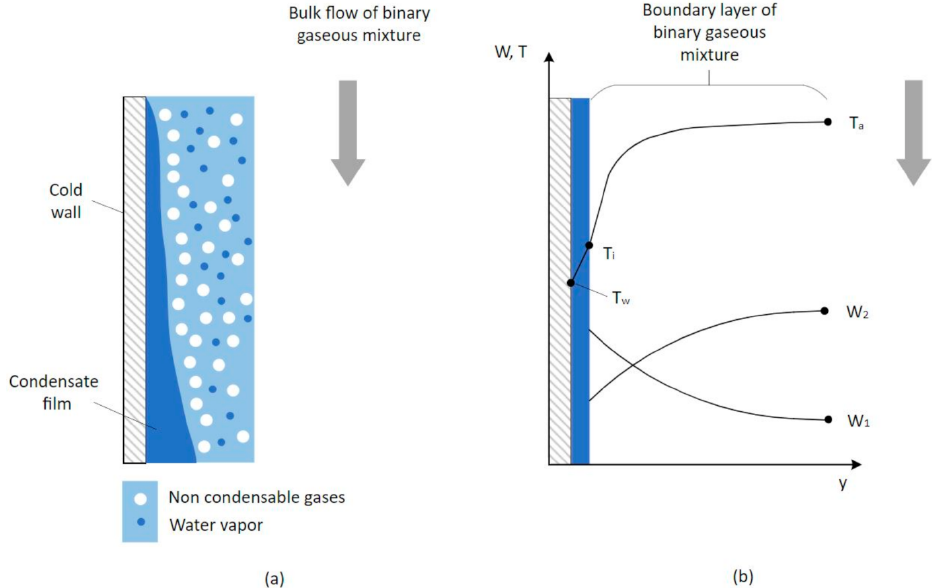
Figure 1. ( a ) Schematic diagram of the condensation of a vapour in the presence of a NCG [2]. The mass fraction of NCG molecules increases at the liquid–gas interface, thus increasing the diffusion resistance of the vapour molecules into the condensate film. ( b ) Variation of mass fractions (W) of the vapour (index 2), the NCG (index 1), and the temperatures of the wall (index w), interface (index i), and bulk-flow mixture (index a) in the direction perpendicular to the bulk flow of the binary gaseous mixture